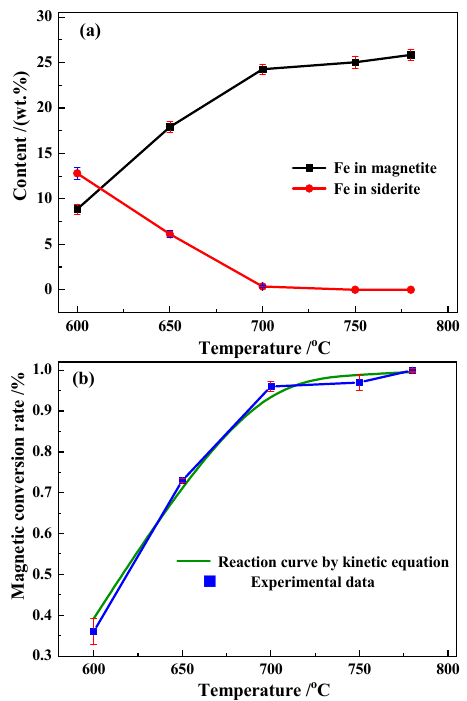
Figure 10. ( a ) Magnetite and ( b ) magnetic conversion curves.